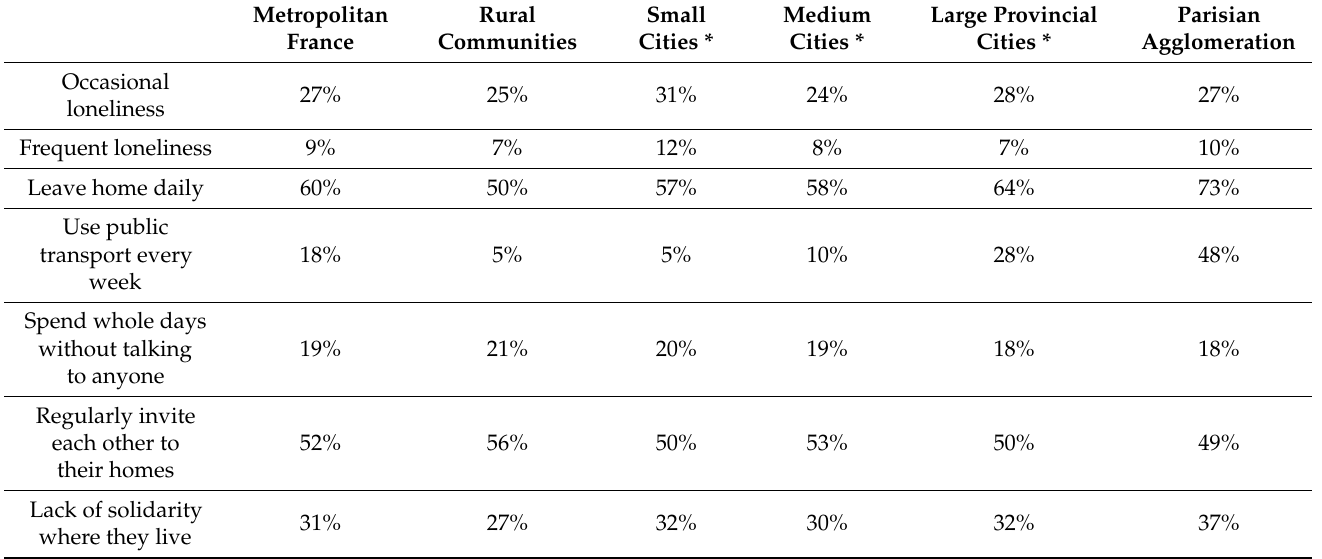
Table 3. Territories, solitudes; summary of key figures by territory